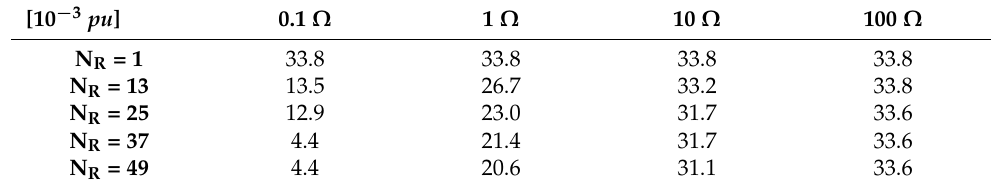
Table 12. MMVME a (23) in the 49-bus network. Earthing resistances are from bus 1 to bus N R . [10 − 3 pu ] 0.1 Ω 1 Ω 10 Ω 100 Ω N R =